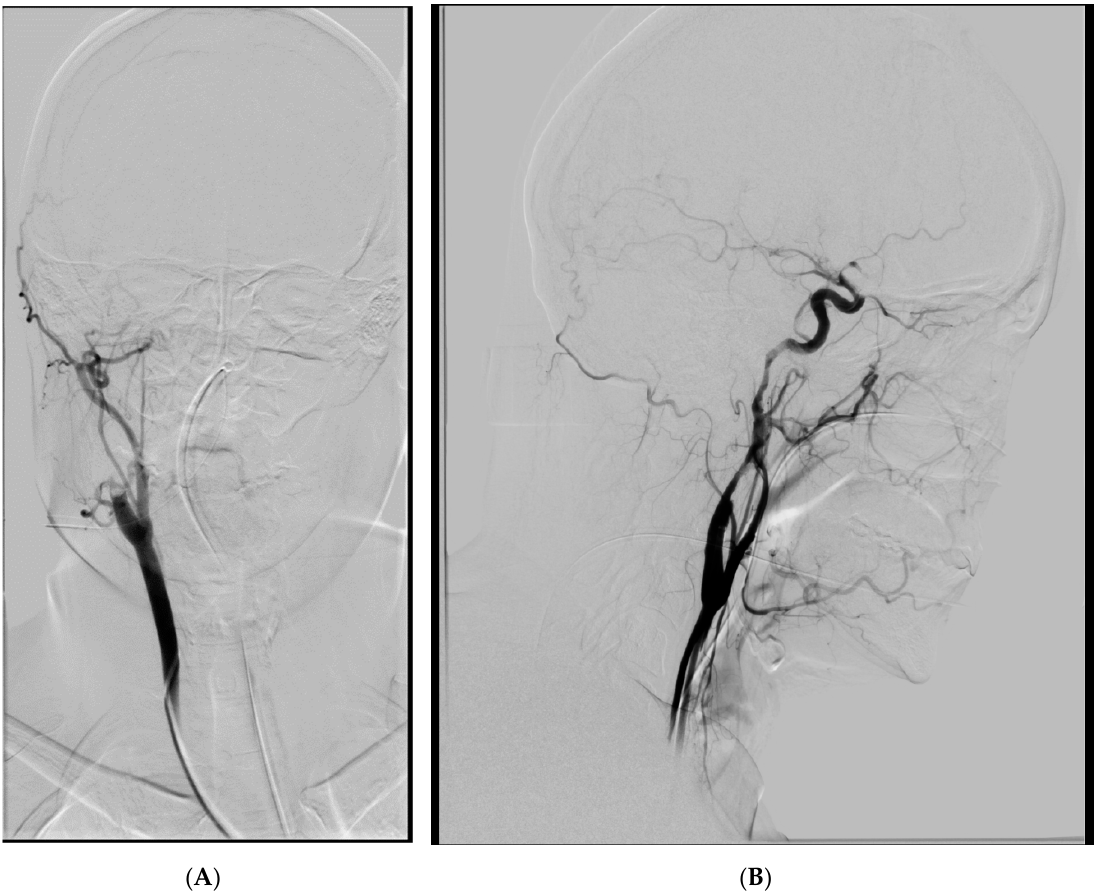
Figure 1. ( A ) Thrombosis and dissection of the right ICA, AP view. ( B ) Extent of the dissection, lateral view.